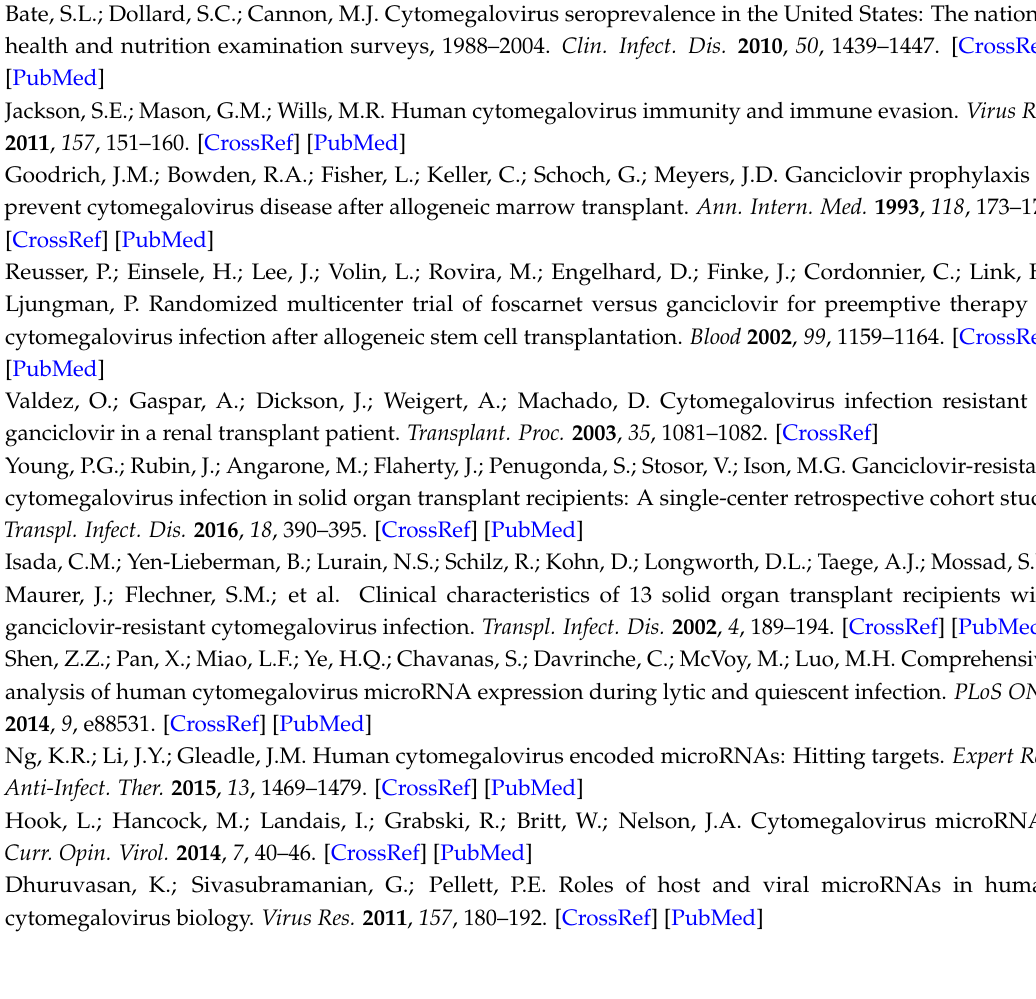
Table S1: Amplification